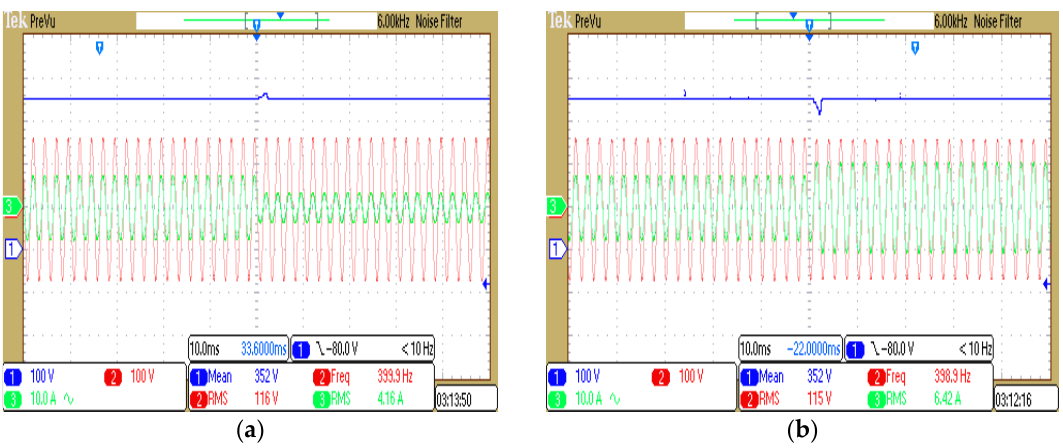
Figure 21. The transient waveforms under the dynamic load power variation. ( a ) The transient waveform of load power from 2.07 KW to 1.08 KW; ( b ) The transient waveform of load power from 1.38 KW to 3.45 KW.